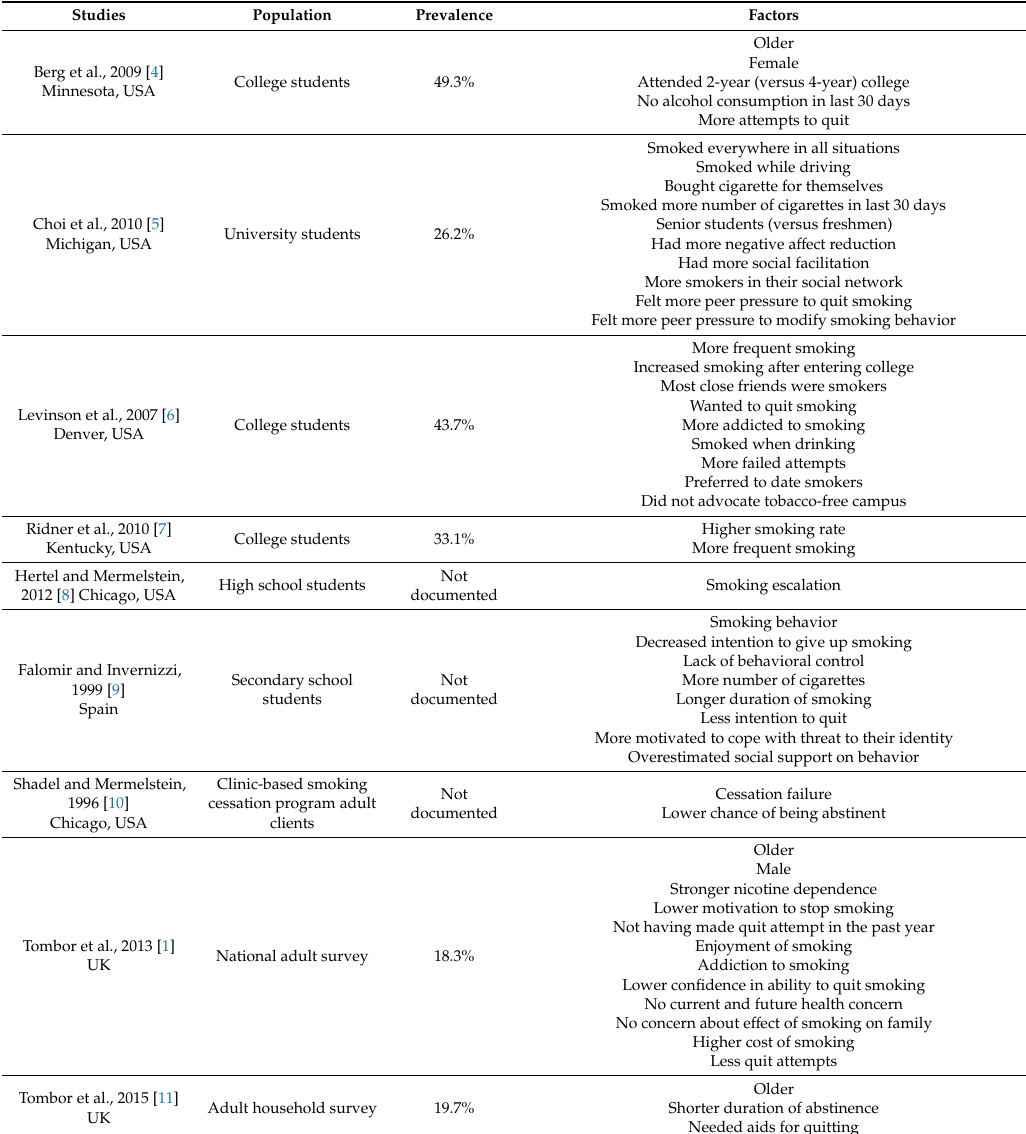
Table 1. Prevalence of positive smoker identity (PSI), or constructs identical to it, and linked, correlated or associated